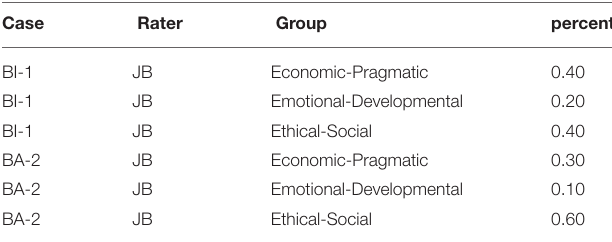
TABLE 2 | Example of the dataset. The sum of the percentages within rater and case must add up to one.